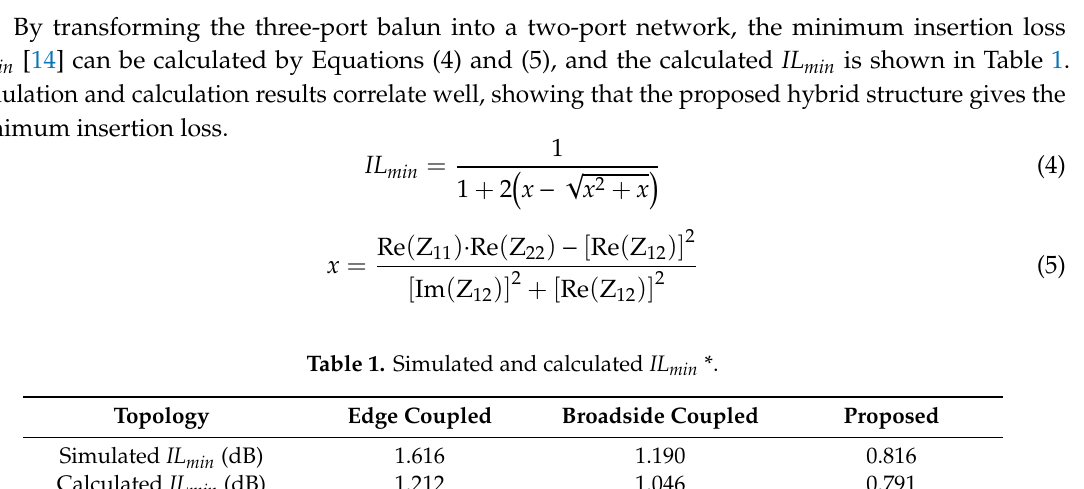
Figure 7. Plot of insertion loss.